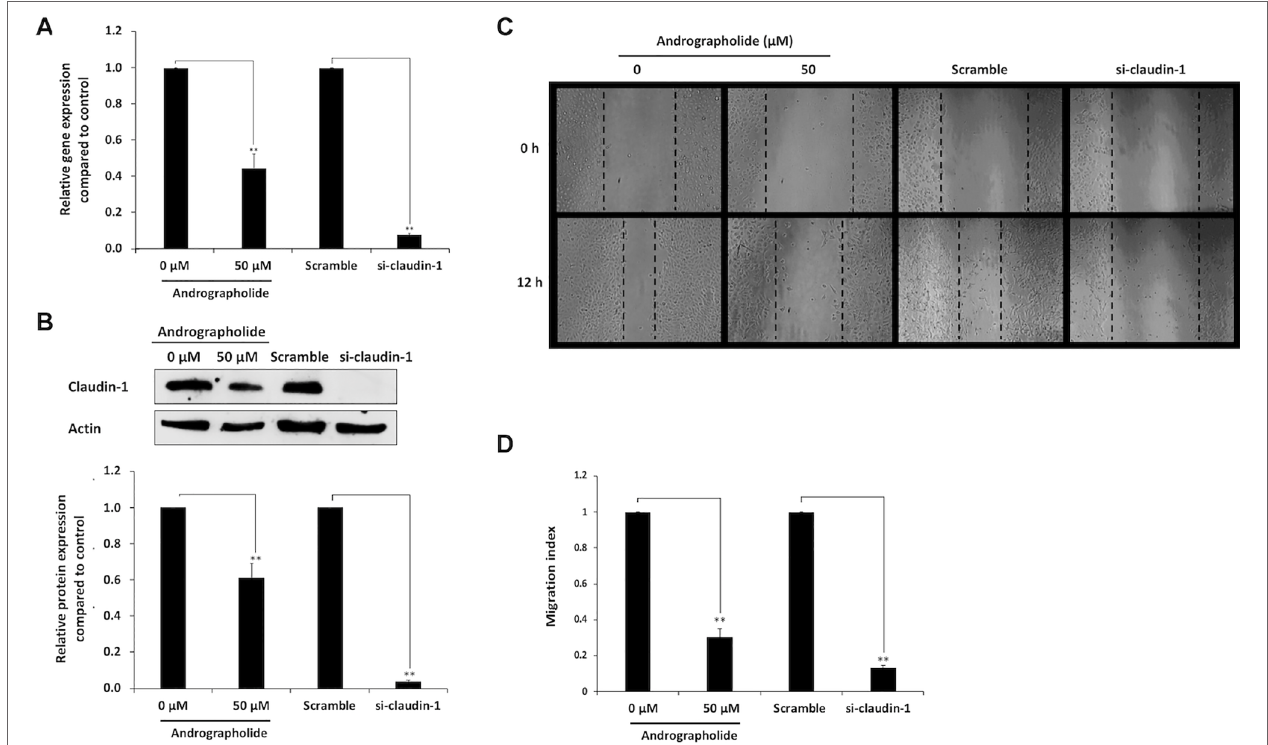
FIGURE 4 | Inhibitory effect of andrographolide on cell migration mediated by claudin-1. The RNA interference of claudin-1 was used to knock down the claudin-1 gene in KKU-M213 cells. KKU-M213 were treated with 0 μM (1% DMSO), 50 μM of andrographolide, scramble, and si-claudin-1 prior to harvesting RNA and cellular proteins for the detection of claudin-1. (A) The expression of claudin-1 mRNA from real-time RT-PCR; (B) The level of claudin-1 protein from Western blot analysis. Actin was used as internal standard. (C) With those treatments, KKU-M213 was scratched to make a wound and photographed at 0 and 12 h to measure the wound length for migration index analysis. (D) The results of bar graph are represented by the average of relative intensity compared with that of control. Data were derived from three independent experiments and are presented as mean ± SE, *p < 0.05, **p <